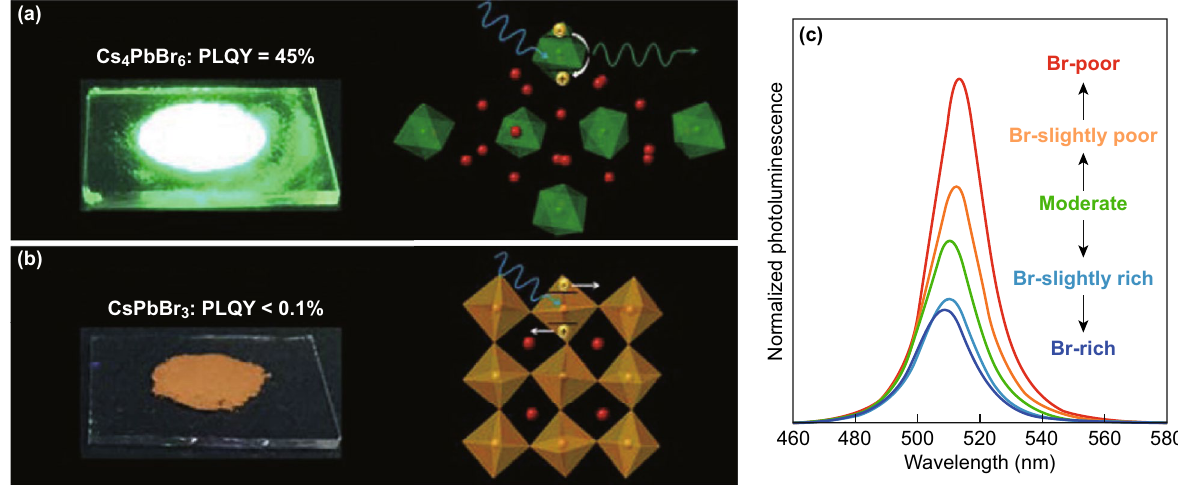
Fig. 6 a , b CsPbBr 3 and Cs 4 PbBr 6 powders on the glass slides under UV light (365 nm). Insets are schematics of their crystal structures [11]. c PL intensity as a function of excitation wavelengths for Cs 4 PbBr 6 . (normalized PL spectra according to the absorbance at an excitation wave- length of 375 nm) [26]. Reprinted with permission from Refs. [11, 26]. Copyright American Chemical